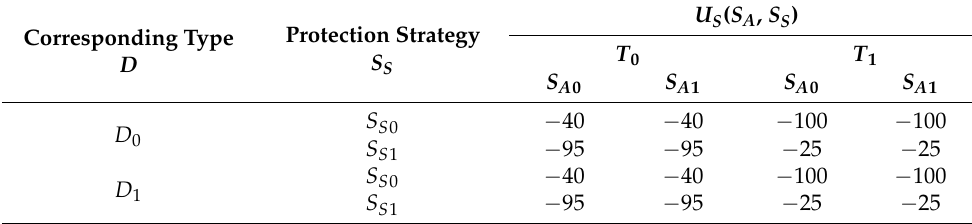
Table 8. Incomes of the Defender.